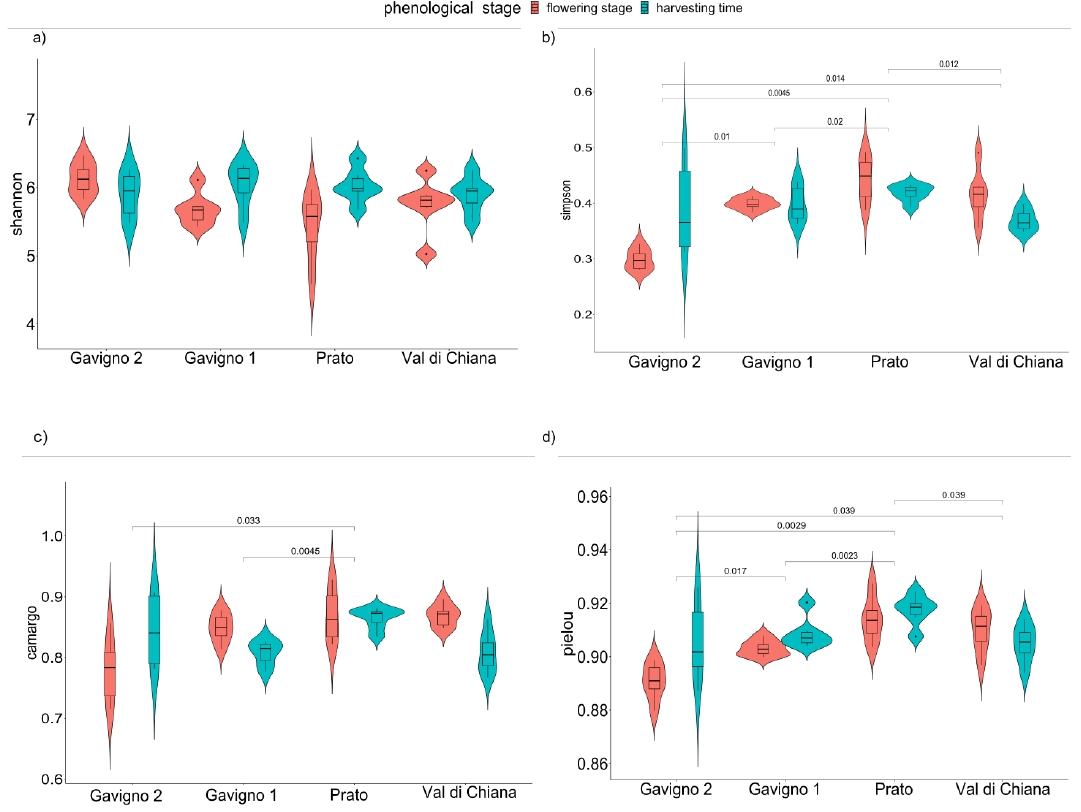
Figure 2. Alpha diversity indices of the samples. ( a ) Shannon index; ( b ) Simpson index; ( c , d ) evenness (Camargo‘s and Pielou’s indices, respectively). Lines and the numbers above the lines indicate the p -values of the contrasts (Wilcoxon test). Table 2. Results of PERMANOVAs on alpha diversity indices, showing the contributions of the locality, the phenological stage, and their interaction. Pseudo F-statistic p -values are reported. n.s., not significant ( p > 0.05).